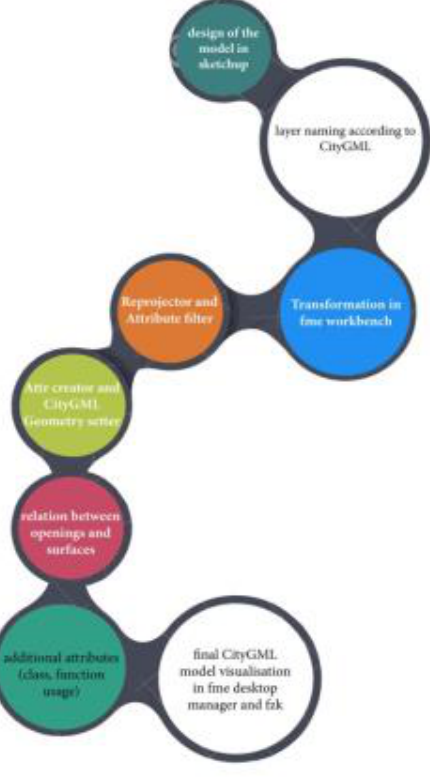
Figure 1: Workflow of the 1st methodology